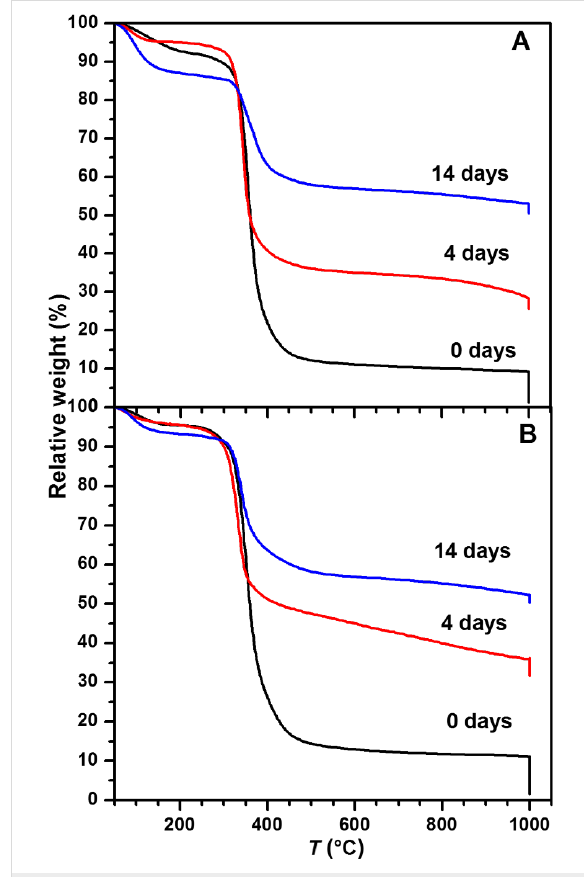
Figure 5: TGA curves for (A) IK24 hydrogels mineralized for 0, 4, and 14 days, respectively, and (B) H3AH3 hydrogels mineralized for 0, 4, and 14 days,